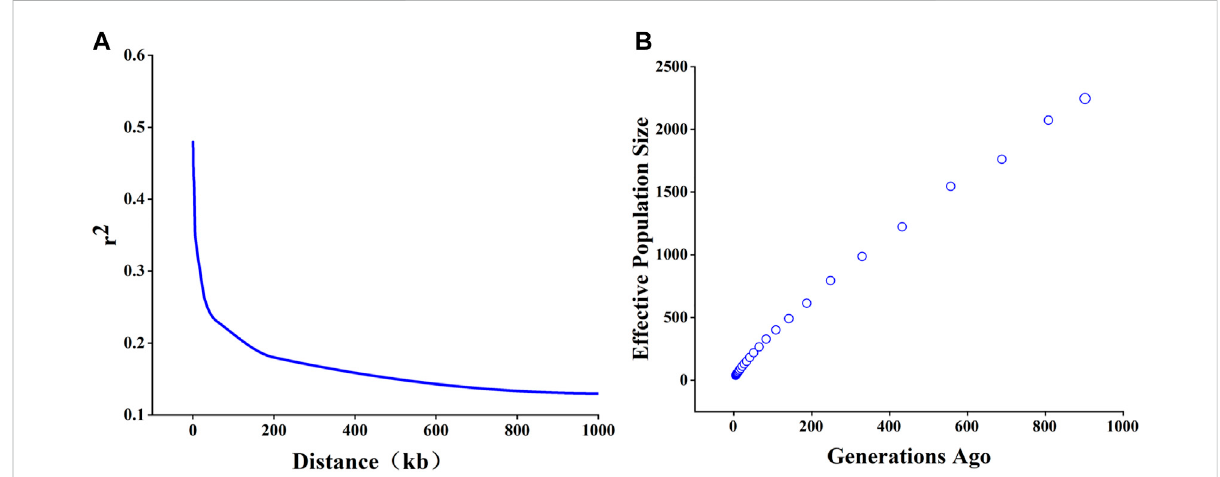
FIGURE 2 Linkage disequilibrium (LD) decay and effective population size (Ne) of Tongcheng (TC) pigs. (A) LD decay of TC pigs. (B) Ne of 68 TC pigs. The time span ranged from prior to generation 1,000 to 1 generation.